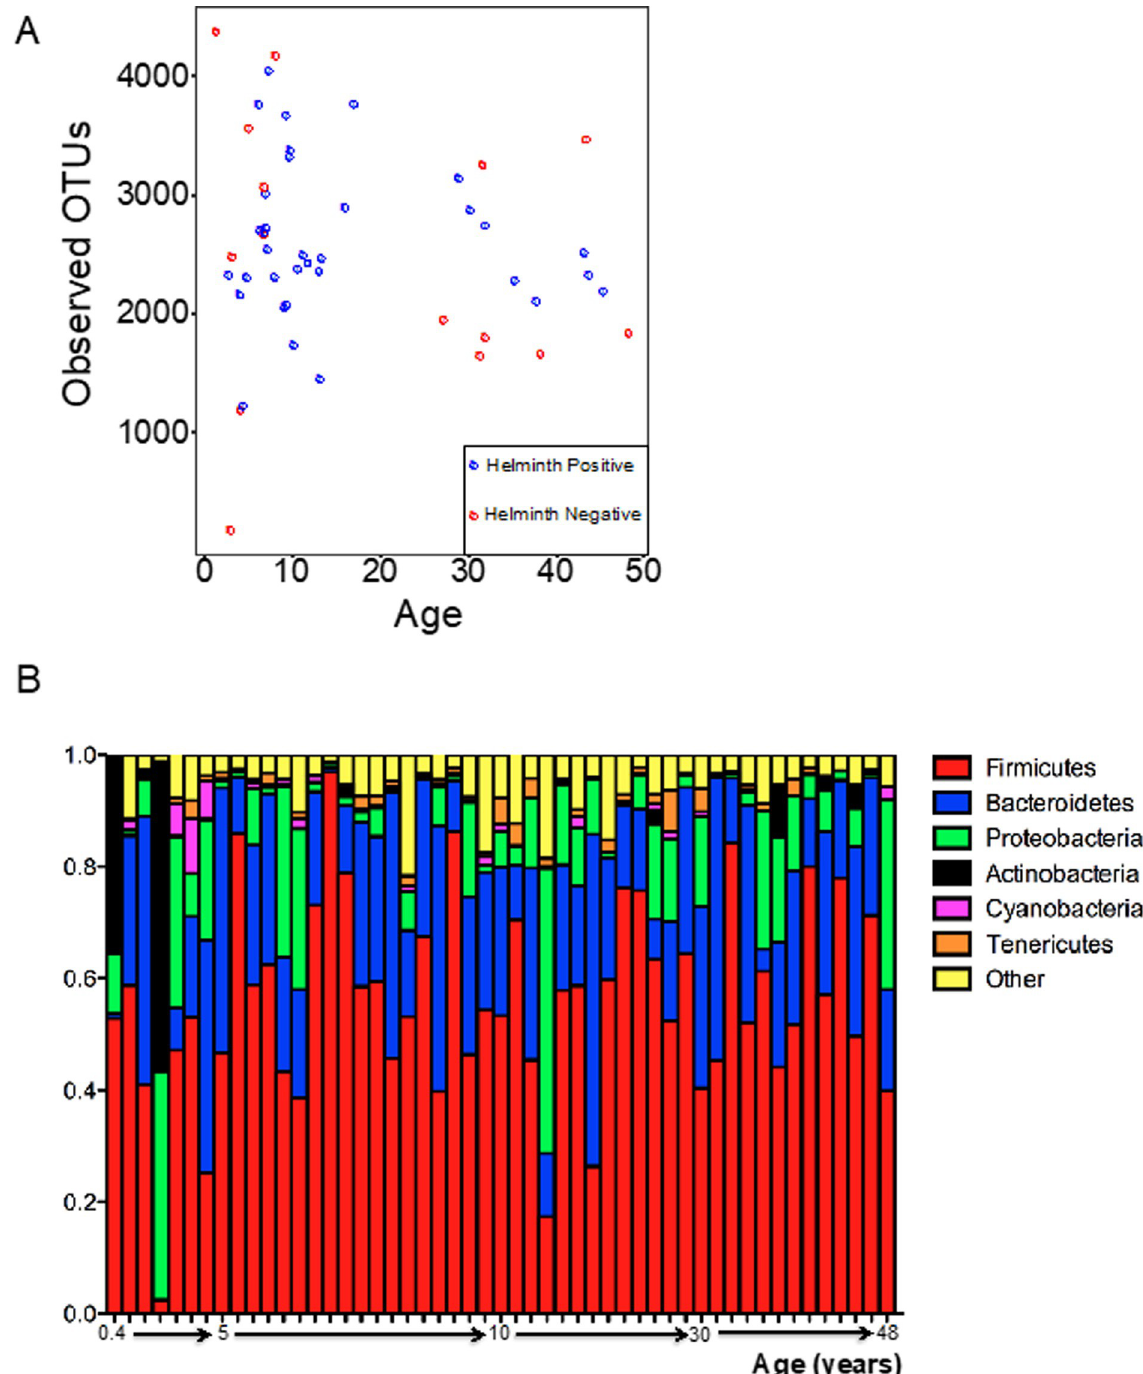
Fig 1. Abundance and diversity in the intestinal microbiome in 51 Malaysian subjects. ( Panel A ) The number of observed OTUs plotted against age for 49 individual samples. The number of observed OTUs for most samples was between 1500–4000. ( Panel B ) Relative abundance of the top phyla represented across the 51 subjects arranged by increasing age. The abundance patterns were largely similar across the individual subjects, except in two of the younger subjects who had high abundance of Actinobacteria ( Bifidobacterium sp.) in their stool